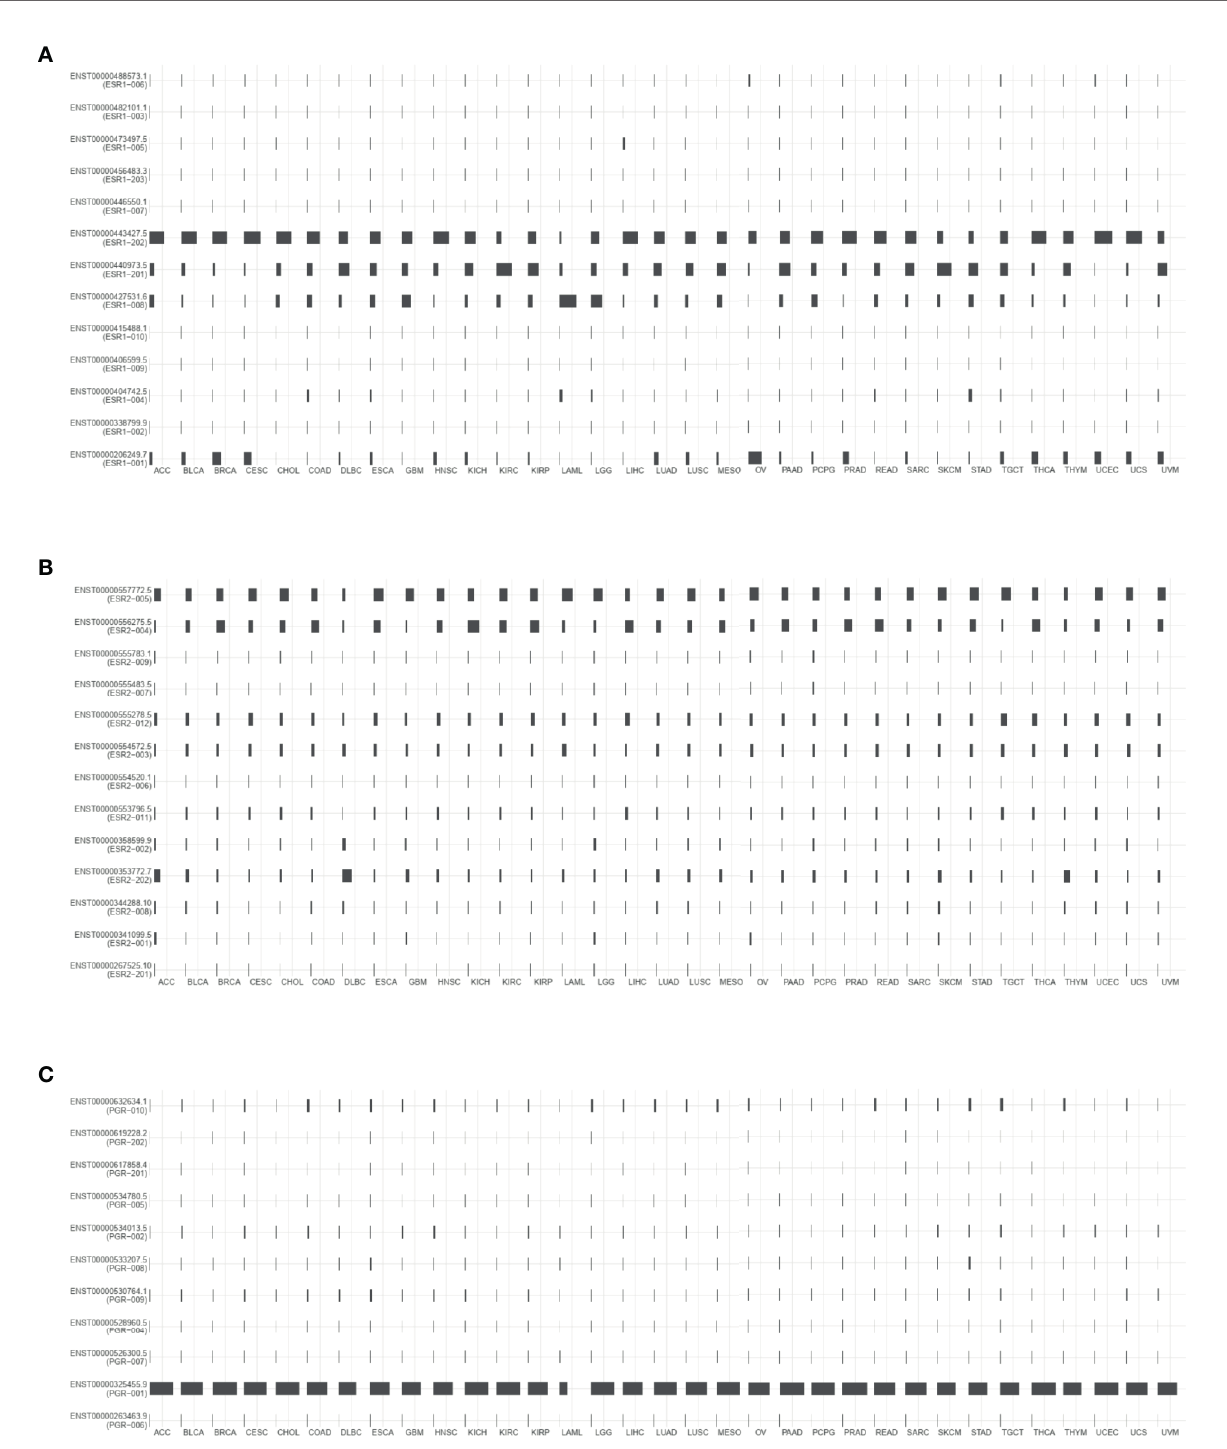
FIGURE 3 | Isoform expression of ESR1 , ESR2 , and PGR genes across multiple cancer types. (A) Isoform expression of ESR1 gene across multiple cancer types. (B) Isoform expression of ESR2 gene across multiple cancer types. (C) Isoform expression of PGR gene across multiple cancer